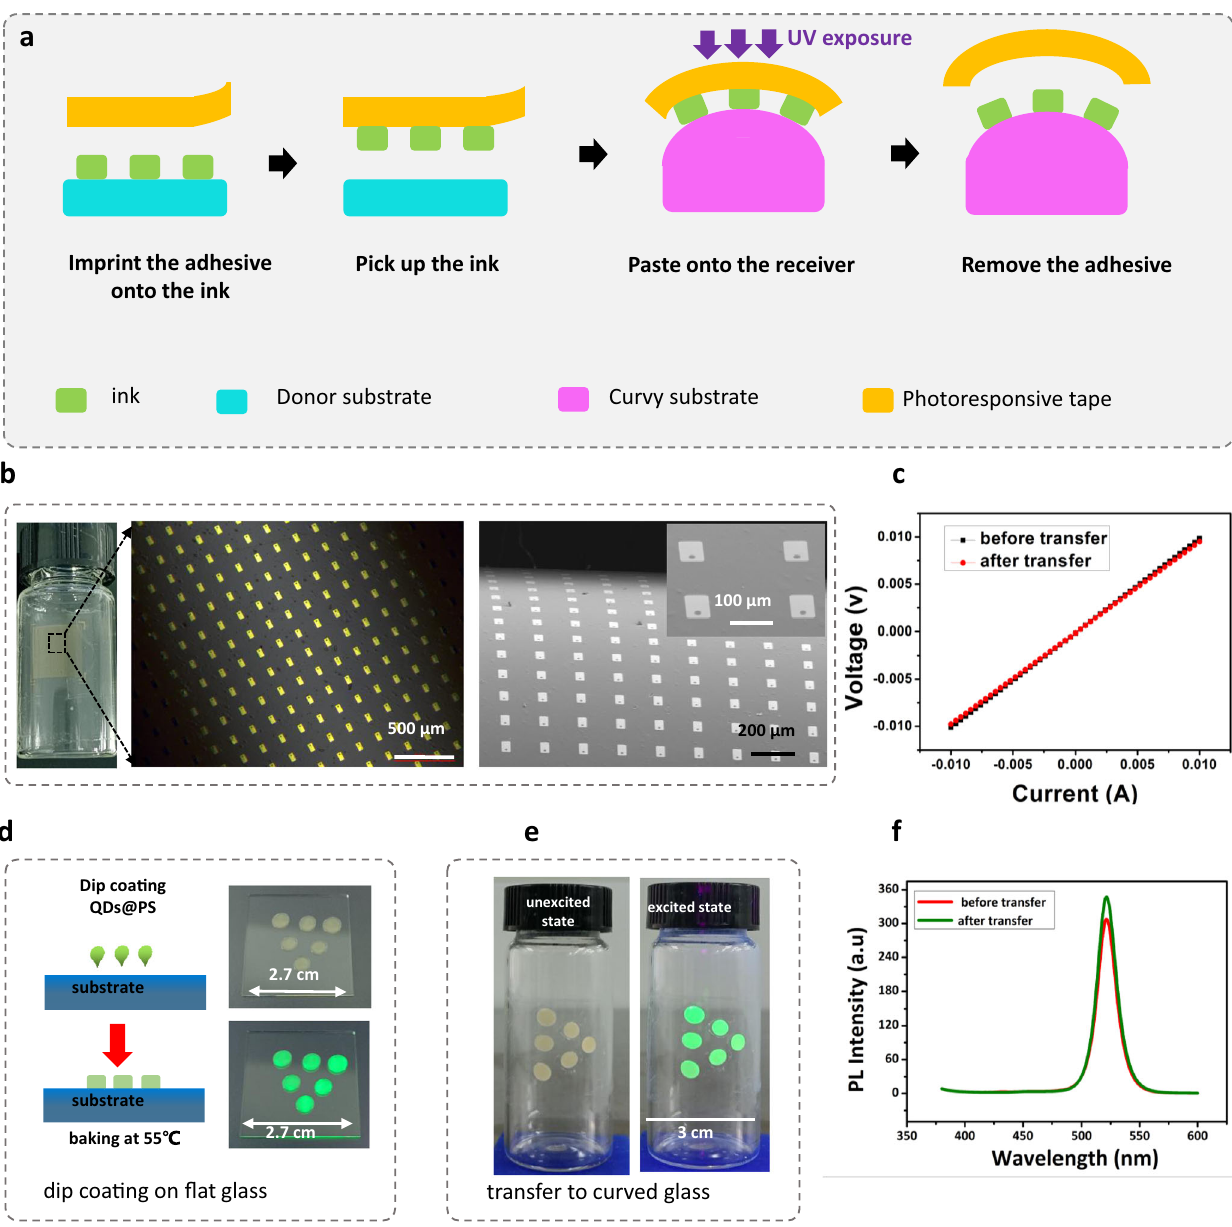
Fig. 5 Transfer printing on curved surfaces. a Schematical transfer printing process on curved surfaces. b Optical and SEM images of the gold nanomembranes transferred to the curvy bottle surface, with a fl ood exposure time of 1.2 s. c I-V characteristics of the gold nanomembrane. d Schematic of the PQD inks formed on a glass substrate by sequential drop coating (Left), and images of the PQD inks before excitation (top right), and after excitation (bottom right). e Optical images of the PQD inks transferred to the bottle surface before excitation (left), and after excitation (right). The fl ood exposure time is 2.5 s. f Photoluminescent (PL) characteristics of the PQDs before transfer and after